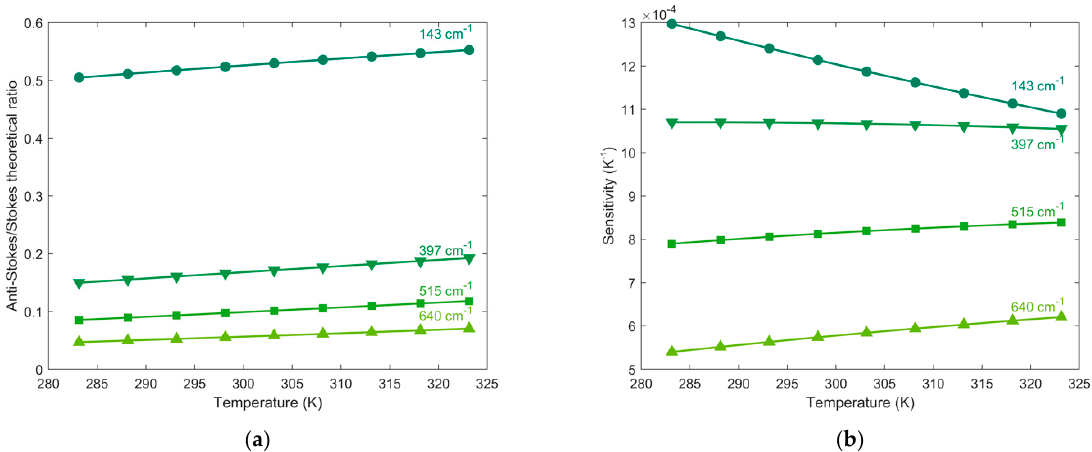
Figure 8. ( a ) Theoretical behavior and ( b ) sensitivity of the anti-Stokes/Stokes ratio of the four anatase modes, at 143, 397, 515, and 640 cm − 1 , calculated with λ exc = 514.5 nm, in the range 283–323 K.